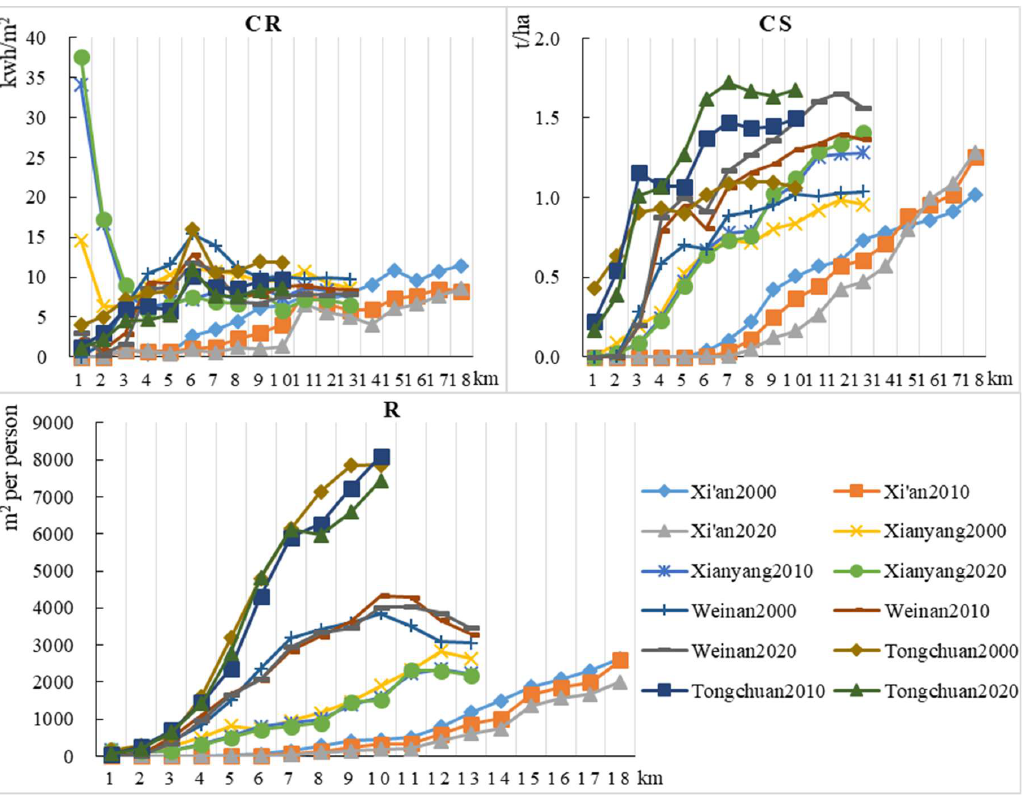
Figure 7. Rural–urban gradient changes in climate regulation (CR), carbon sequestration (CS), and recreation (R) in the XMA in 2000, 2010, and 2020. Each point represents the average value of ecosystem services within a concentric circle.